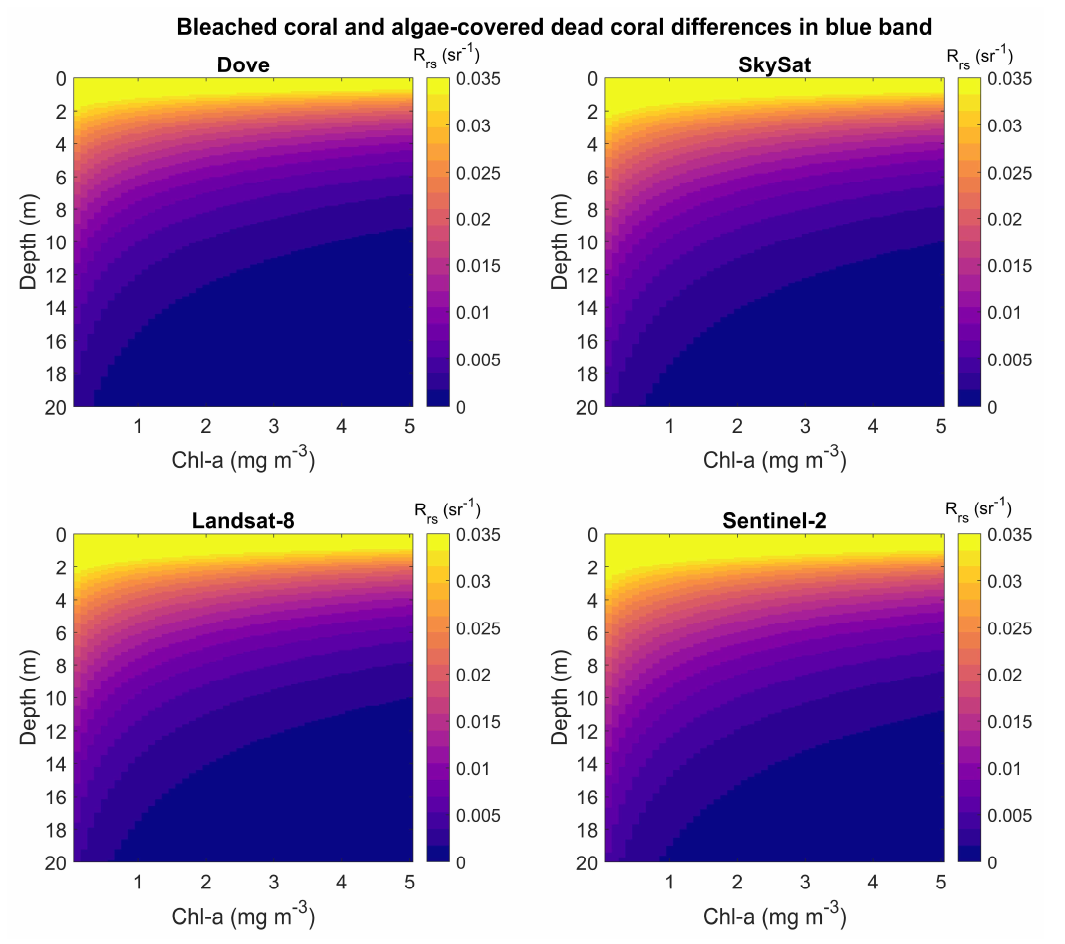
Figure 7. Differences of remote sensing reflectance between the bleached coral and algae-covered dead coral in the blue spectral bands of four different satellite sensors.